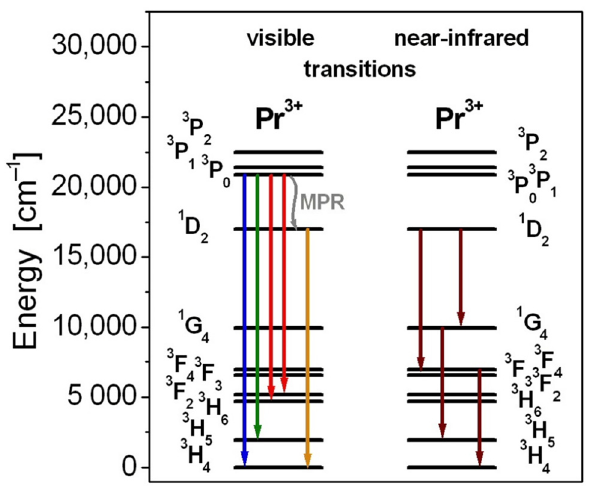
Figure 2. Energy level diagram of praseodymium ions in inorganic glasses. The spectroscopic results for Pr 3+ ions in fluoride glass based on InF 3 (IZSBGL-Pr), borate glass with Ga 2 O 3 and BaO (BBG-Pr), lead-phosphate glass with Ga 2 O 3 (PPG-Pr), and gallo-germanate glassses modified by BaO/BaF 2 (referred to as GBG-Pr and GBFG- Pr) are presented and discussed here.